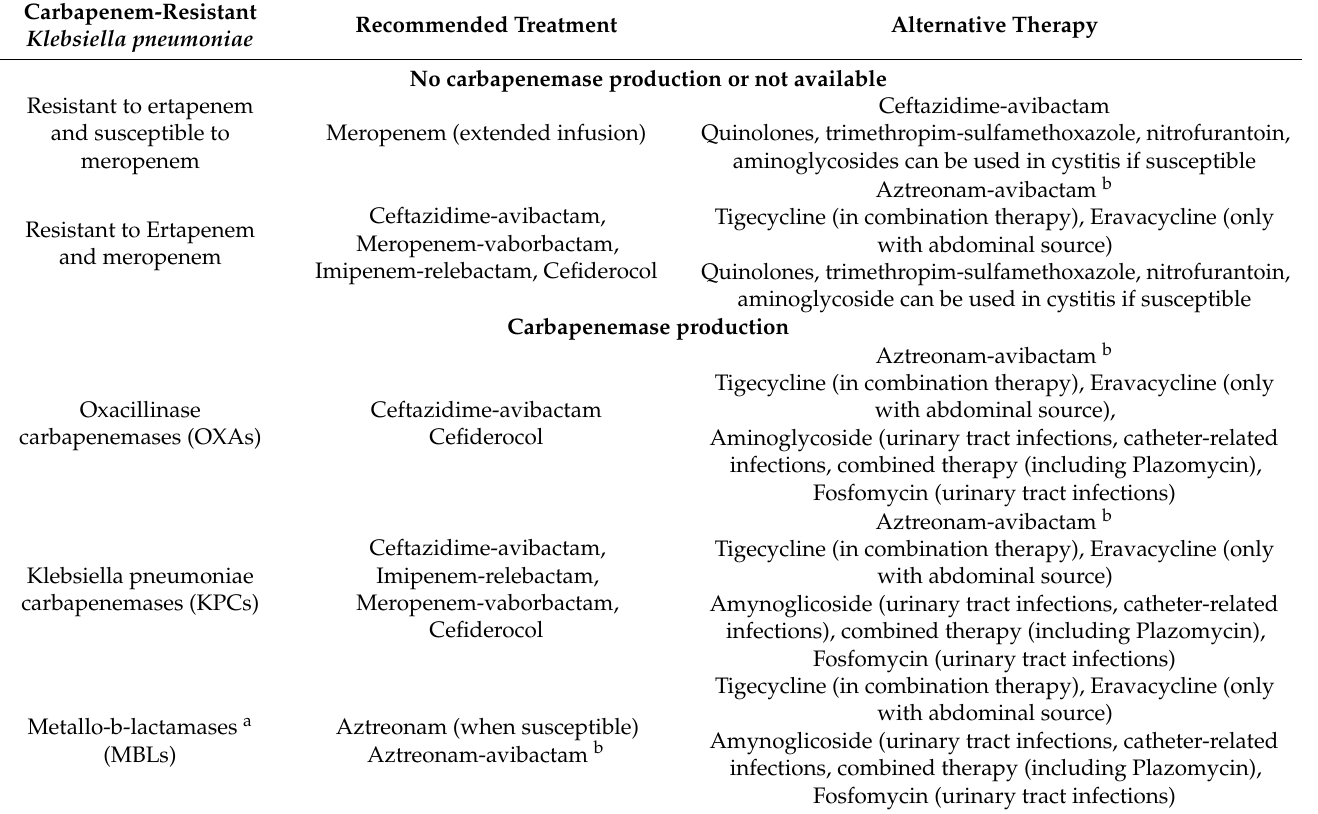
Table 5. Treatment recommendations for CR-Kp infections in critically ill